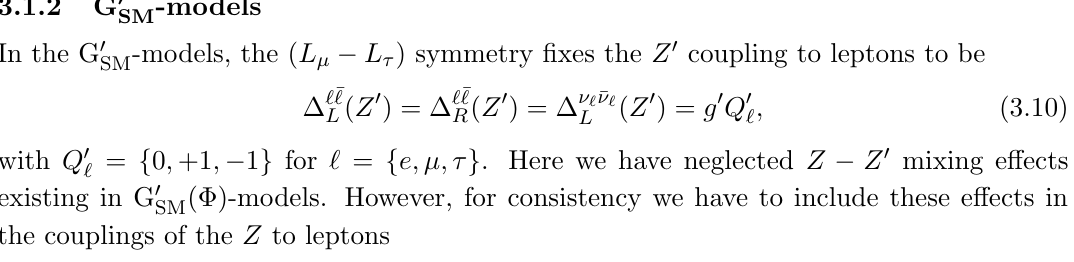
(cid:21) V u ), see i ! i